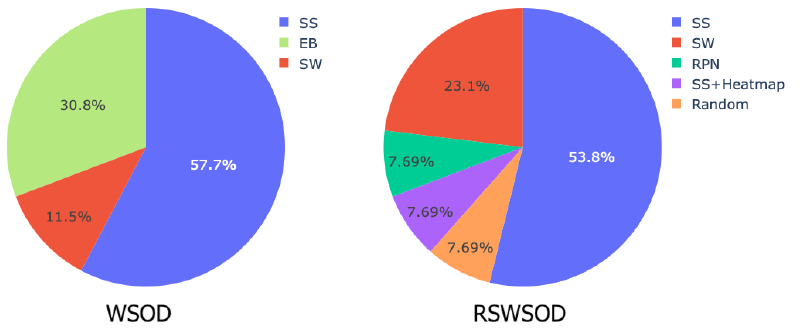
Figure 7. Type of proposals used in WSOD and RSWSOD MIL-based methods. SS stands for Selective Search, EB for Edge Boxes, SW for Sliding Window, and RPN for region proposal network. It is possible to notice that in both cases, Selective Search is the most used proposal generation technique. WSOD data are provided by